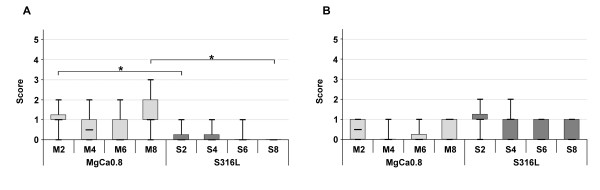
Boxplots of the immunohistochemical evaluation of cranial tibial muscle cross sections after implantation of MgCa0.8 (light grey boxplots) and S316L (dark grey boxplots) for two, four, six and eight weeks (two weeks is represented as M2 for MgCa0.8 and as S2 for S316L, four weeks as M4 for MgCa0.8 and S4 for S316L, etc.). The boxplots represent the amount of (A) B-lymphocytes and (B) T-lymphocytes. Non parametrical tests (Mann-Whitney-Tests) were calculated to determine differences between the implant materials. Stars represent significant difference, which was defined as p < 0.05.